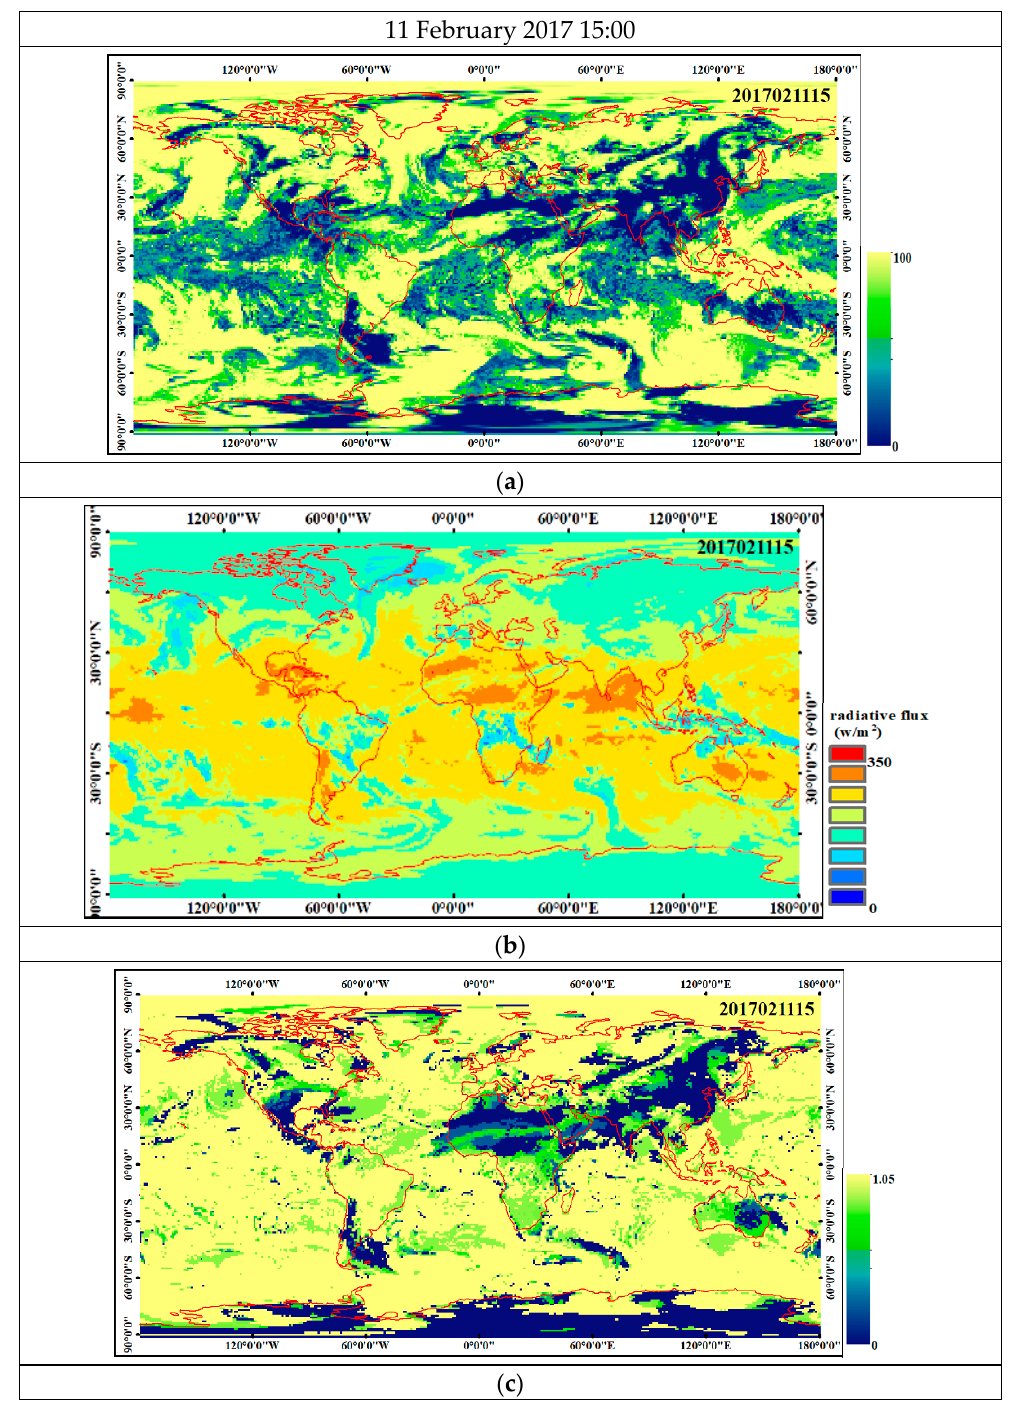
Figure 4. Cloud fraction ( a ) of ERA5 at 3:00 p.m. on 11 February 2017, TOA longwave radiative flux derived from EAR5 ( b ) and cloud effective emissivity ( c ) derived using Equation (12) with cloud base height data.